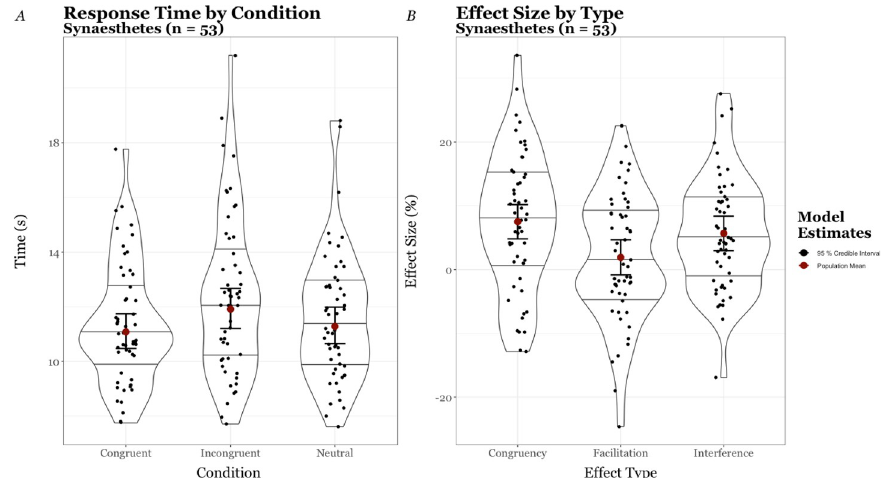
Fig 2. Synaesthetes’ response times. Panel A–Violin plots with superimposed jitter plots for synaesthetes’ (n = 53) median item times (s) by condition with accompanying model estimates of the population mean and Panel B–Violin plots with superimposed jitter plots for synaesthetes’ (n = 53) effect size by type with accompanying model estimates of the population effect sizes.